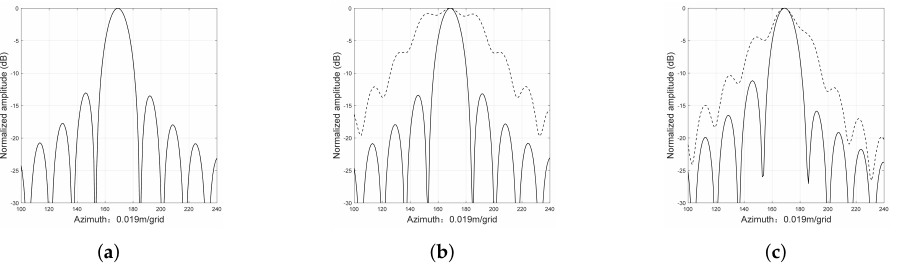
Figure 11. The azimuth profiles processed by proposed signal model and signal model in [16] of ( a ) Point 1, ( b ) Point 2 and ( c ) Point 3 in Figure 10. The solid and dotted profiles represent the results of proposed signal model and signal model in [16],